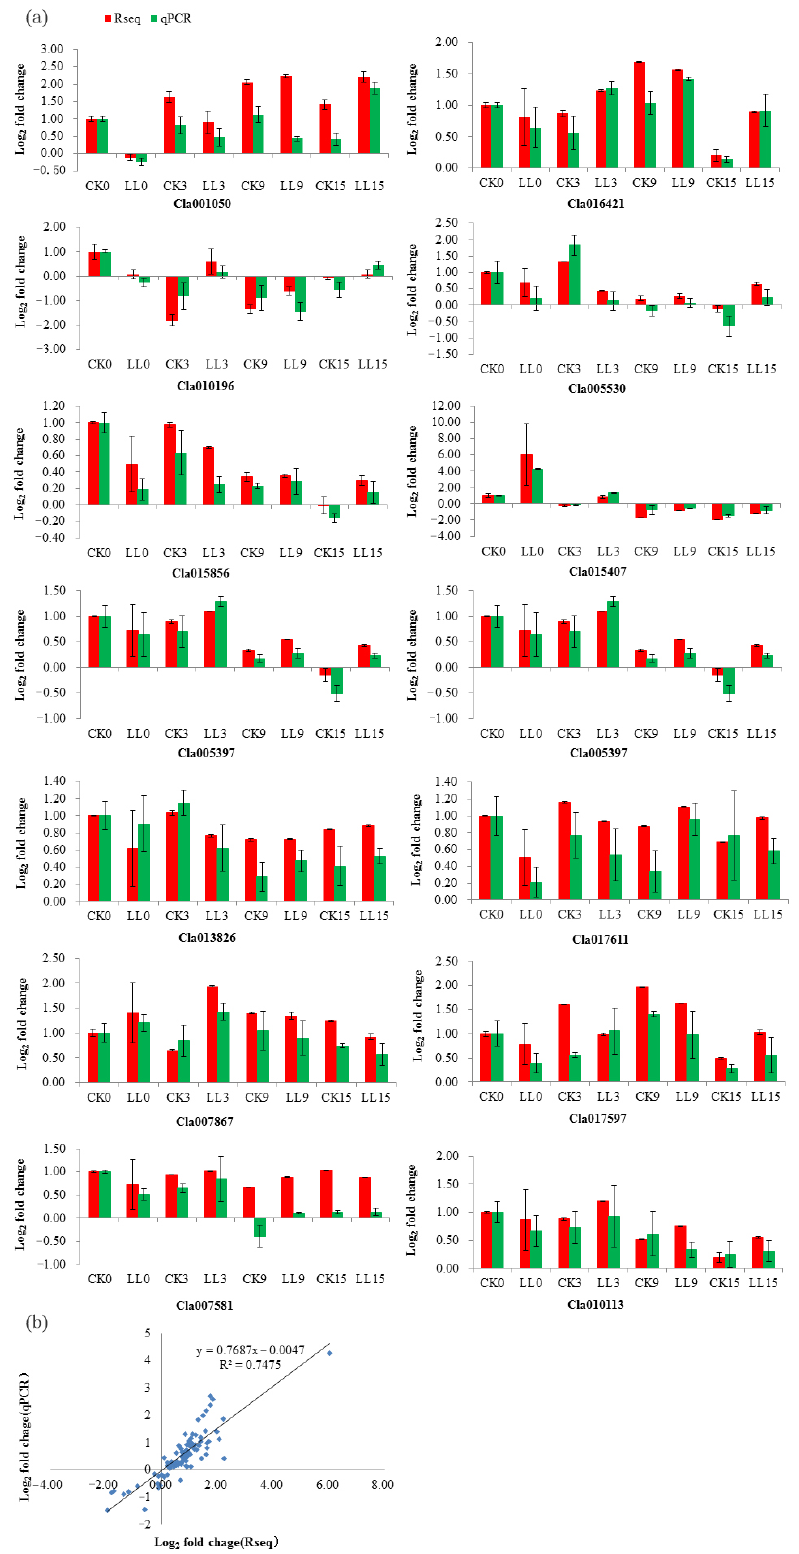
Figure 7. Verification of the expression of selected DEGs by qRT-PCR. ( a ) Log 2 fold change of 14 genes under control and low-light stress at four developments of watermelon fruit. The bars represent the mean of three biological replicates ± standard errors. ( b ) Log 2 fold change of RNA-seq ( X -axis) and qRT-PCR ( Y